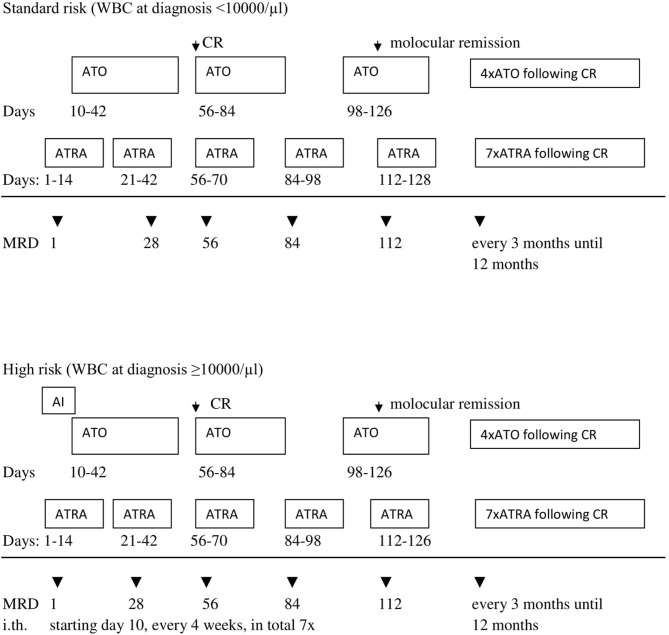
Second period (AML-BFM 2012) treatment scheme. AI—cytarabine 100 mg/m2/day [days 1–2] and 100 mg/m2 every 12 h [days 3–8], idarubicin 12 mg/m2/day [days 3, 5, and 7]. ATRA—all trans-retinoid acid 25 mg/m2/day oral in two divided doses for 14 days. ATO—arsentrioxide 0.15 mg/kg/day, starting at day 10 until morphologic CR, after 2 weeks brake: 4 cycles Monday–Friday 0.15 mg/kg/day i.v. for 4 weeks and 4 weeks break. MRD, minimal residual disease; i.th., intrathecal cytarabine in the age-depended dose (<1 year 20 mg; 1–2 years 26 mg; 2–3 years 34 mg; >3 years 40 mg). CR, complete remission.